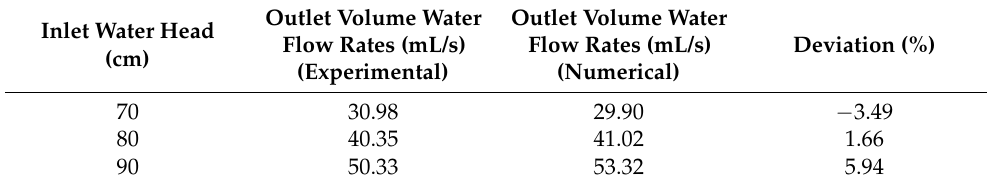
Table 2. Comparison between the numerical and experimental outlet volume water flow rates.